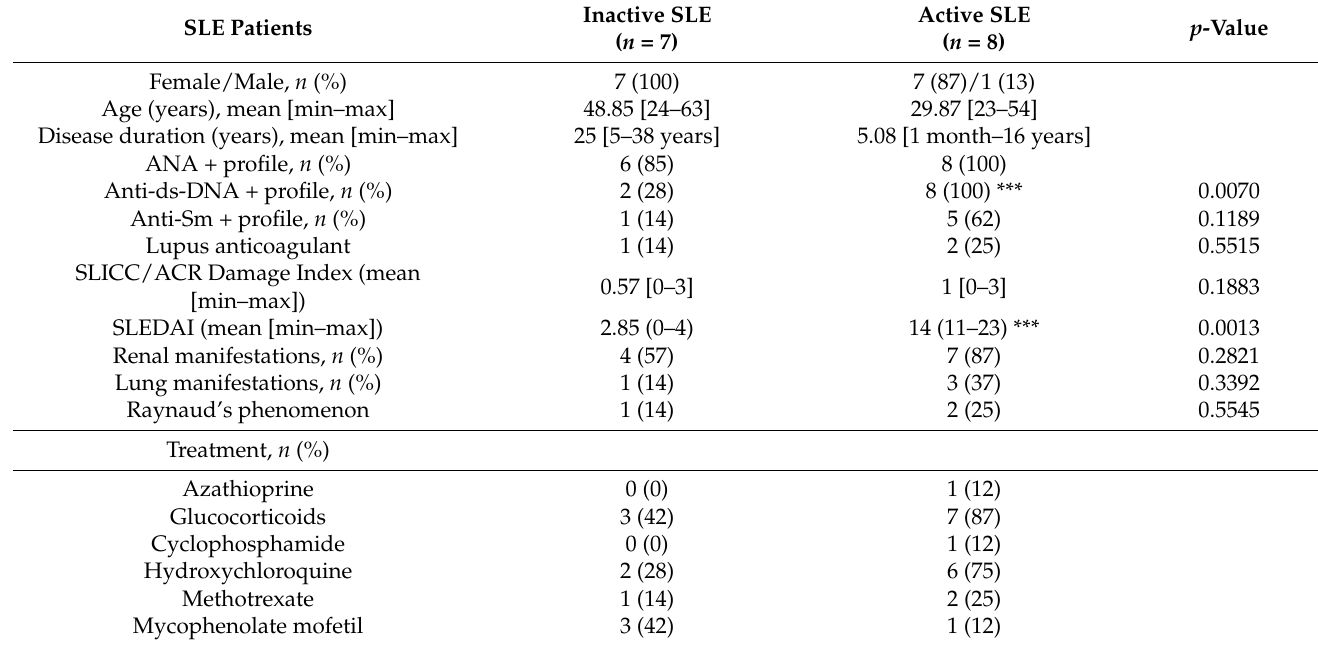
Table 2. Clinical features and treatment of SLE patients participating in the in vitro experimental